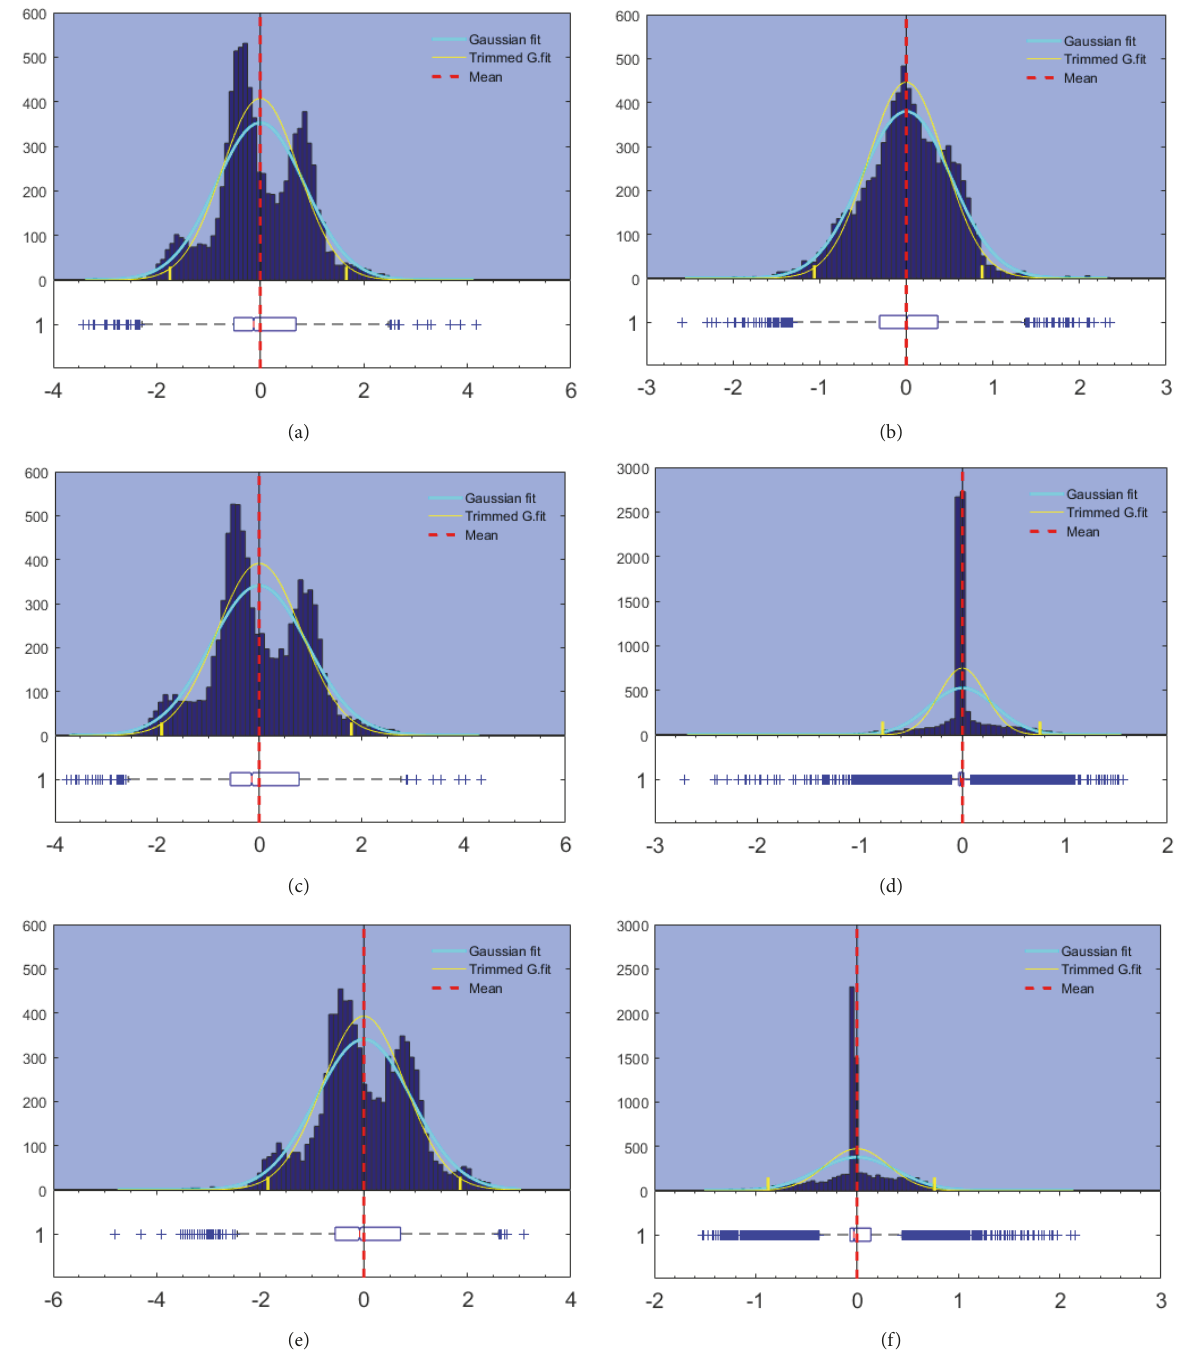
Figure 28: Histogram and fitted normal PDF and IC1/IC2 component activity. (a) IC1 from mixed O1-O2. (b) IC2 from mixed O1-O2. (c) IC1 from mixed O1-ACO. (d) IC2 from mixed O1-ACO. (e) IC1 from mixed O2-ACO. (f) IC2 from mixed